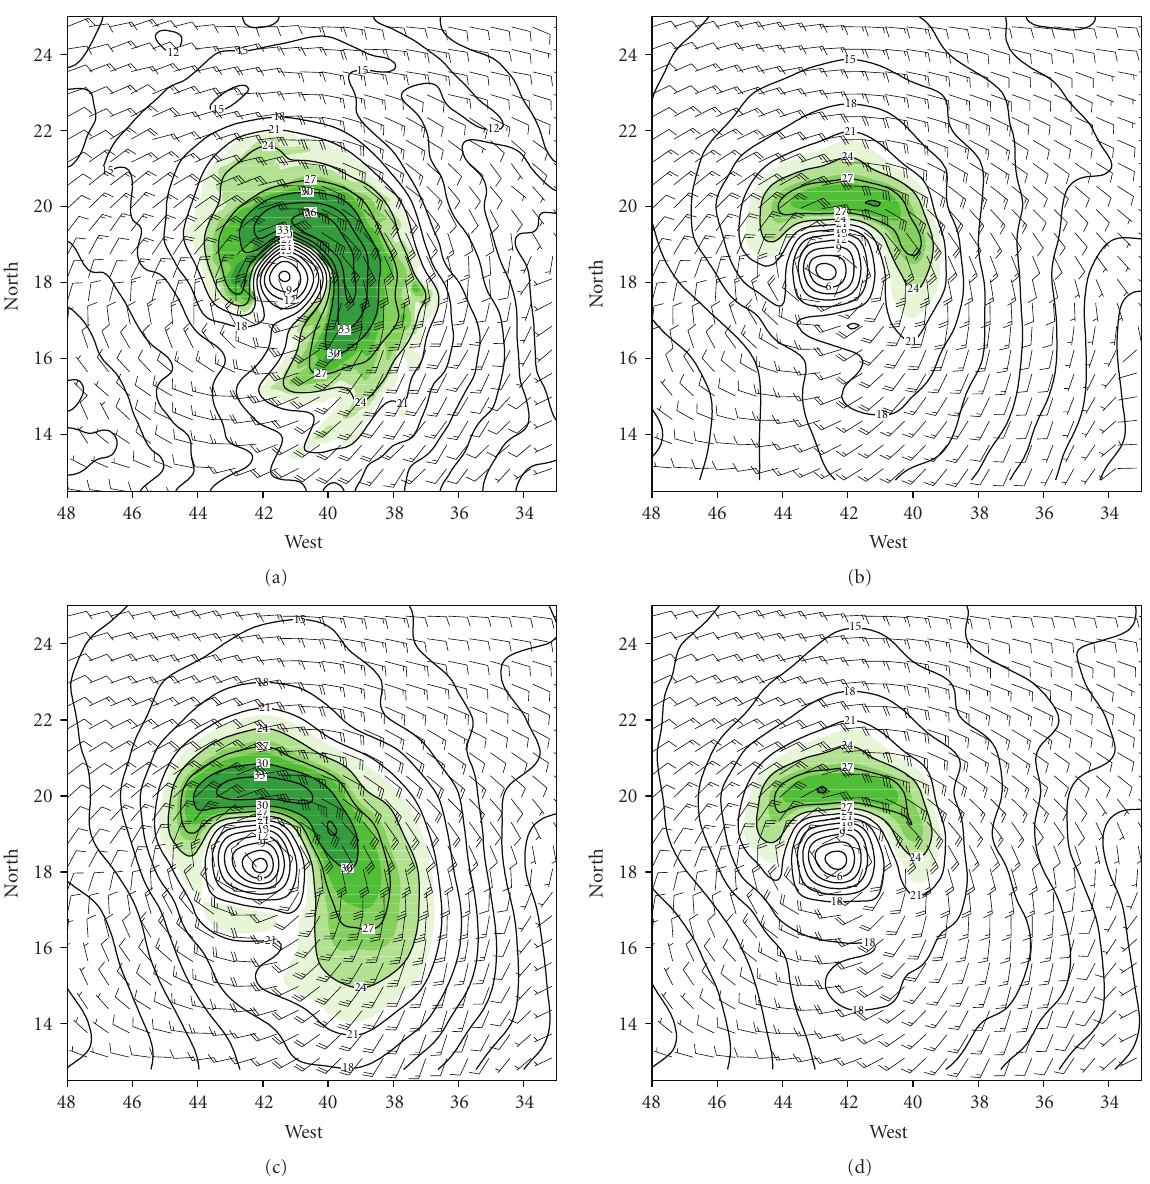
Figure 3: Horizontal wind structure (wind speed contour and wind vector) at the storm center at 850 hPa from (a) regional nature run, (b) control run, (c) data assimilation Experiment 1, and (d) data assimilation Experiment 2 at 0600 UTC 01 October 2005. The contour interval of wind speed is 3ms − 1 , the areas with wind speed exceeding 20ms − 1 are